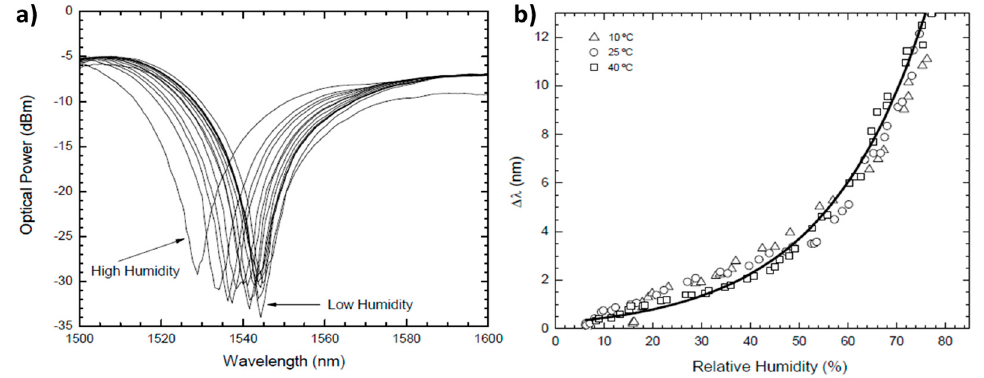
Figure 15. ( a ) Experimental results for different relative humidity levels; ( b ) Relative resonance wavelength shift with relative humidity levels for different temperature values. Reprinted with permission from Ref. [92].